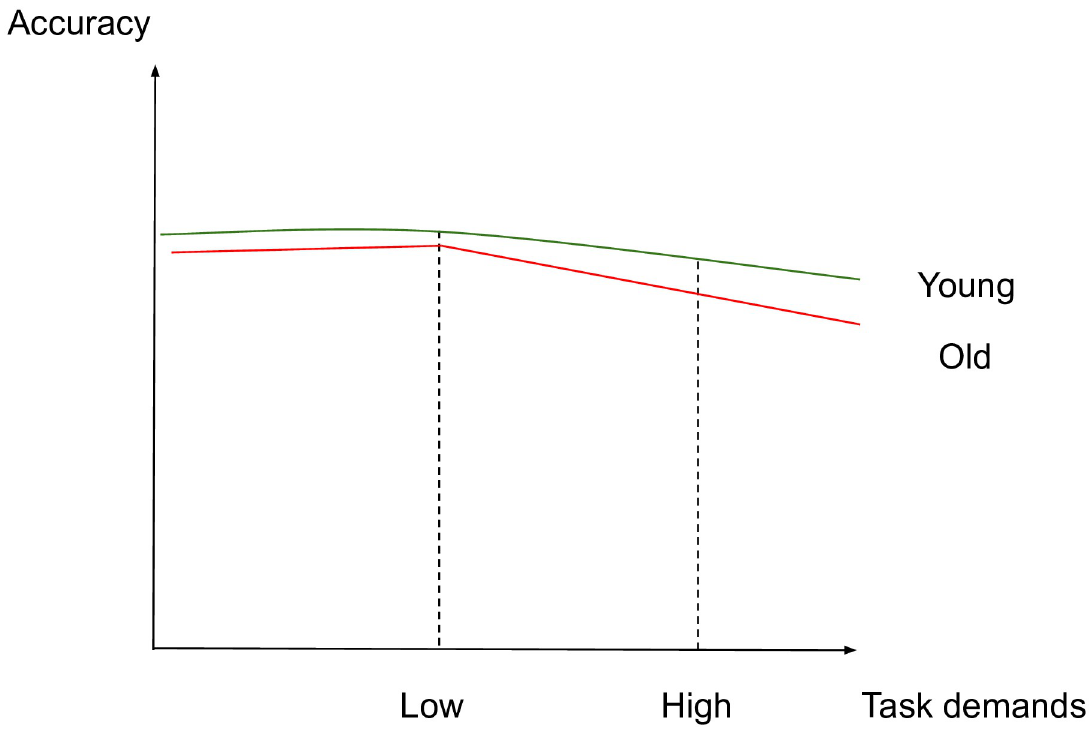
Fig 1. Accuracy and task demands in younger and older adults.